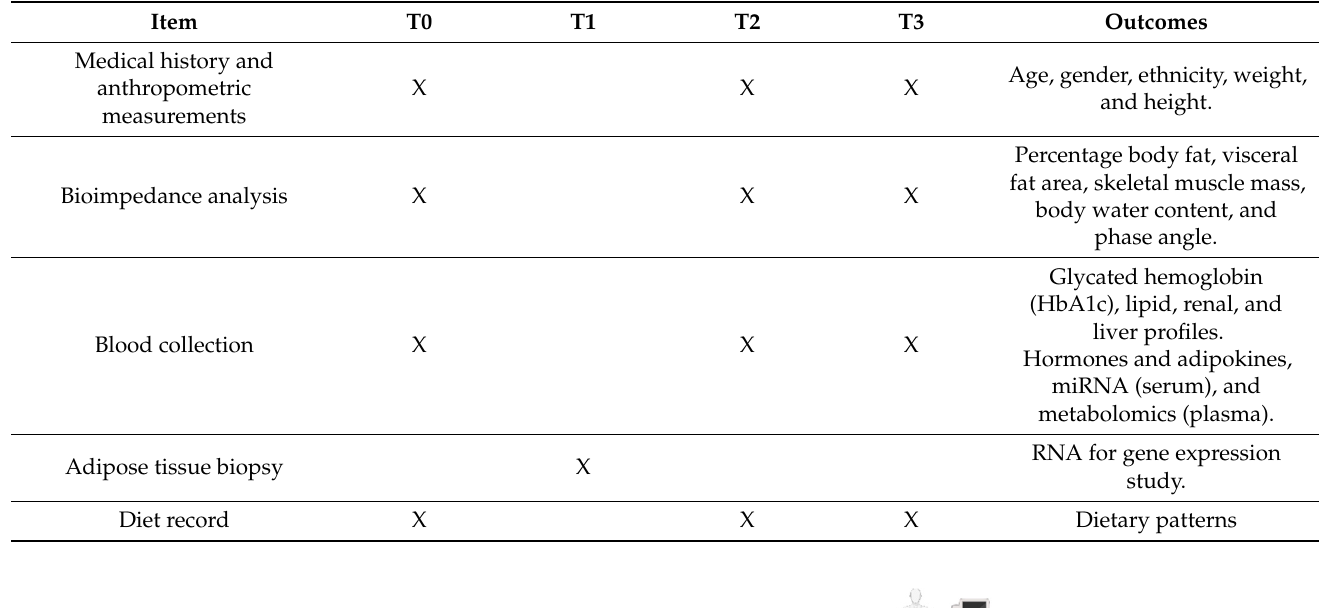
Table 1. The time points of sample collection and clinical and laboratory analyses. T0 indicates pre- operatively, T1 indicates during operation, T2 indicates 6 ± 1 months after the operation, and T3 indicates 12 ± 1 months after the operation.